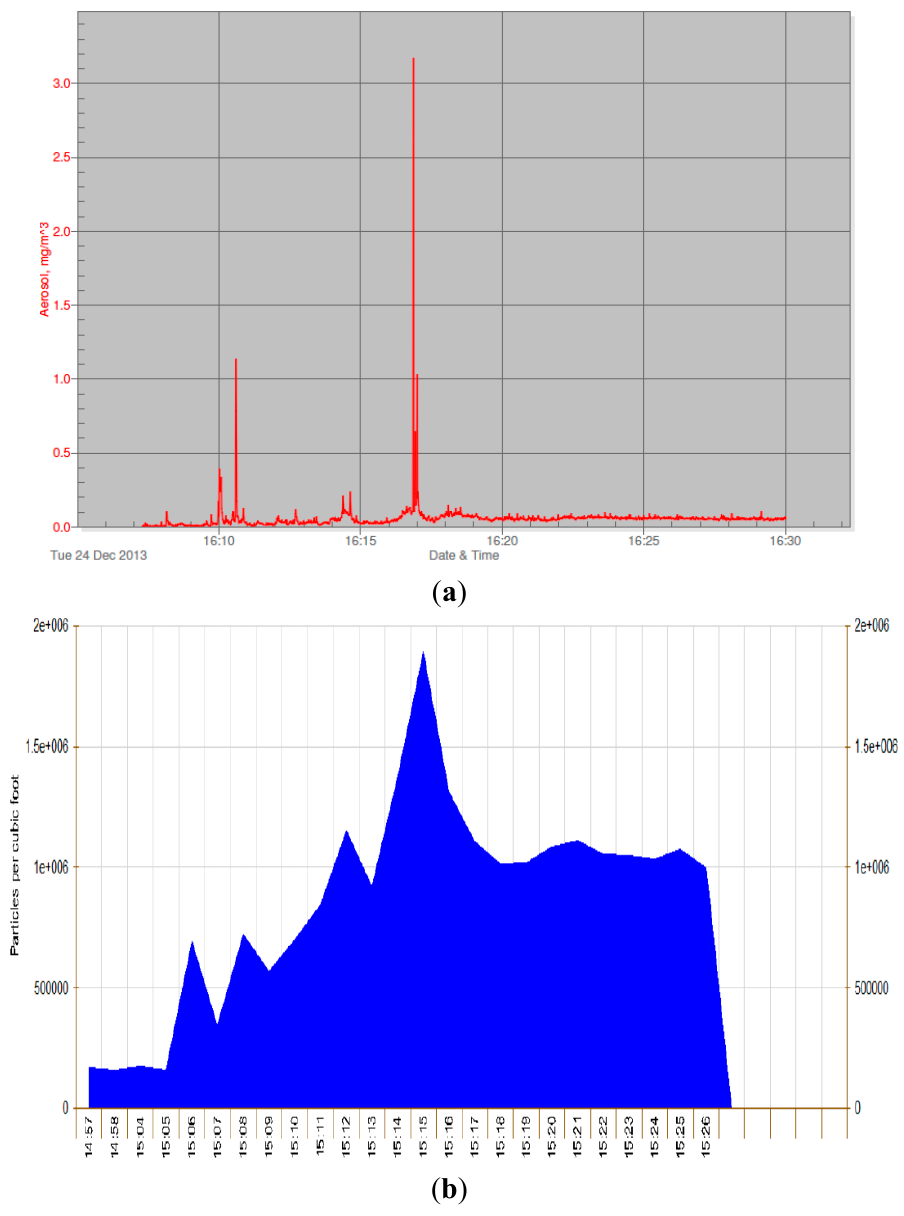
Figure 3. Real-time PM monitoring—simultaneous test with ( a ) Sidepak and ( b ) Dylos.